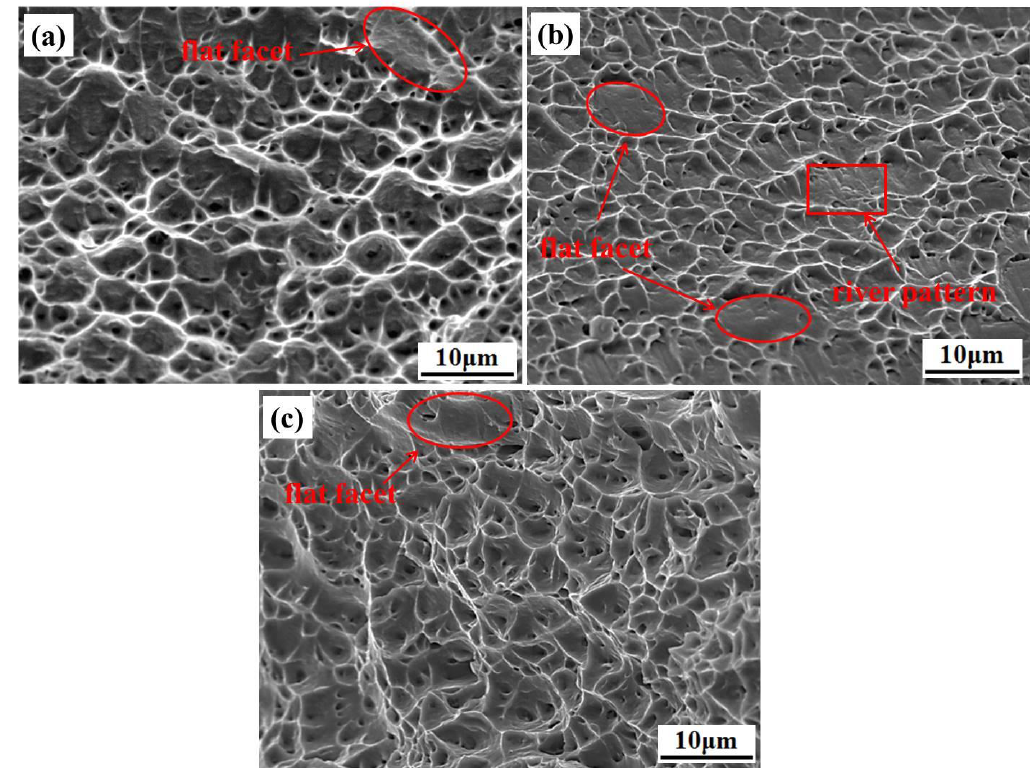
Figure 4. SEM images of the fracture surfaces of the three alloy foils in the peak-aged condition. ( a ) Cu-3Ti; ( b ) Cu-Ti-Fe; ( c ) Cu-Ti-Fe-Cr.